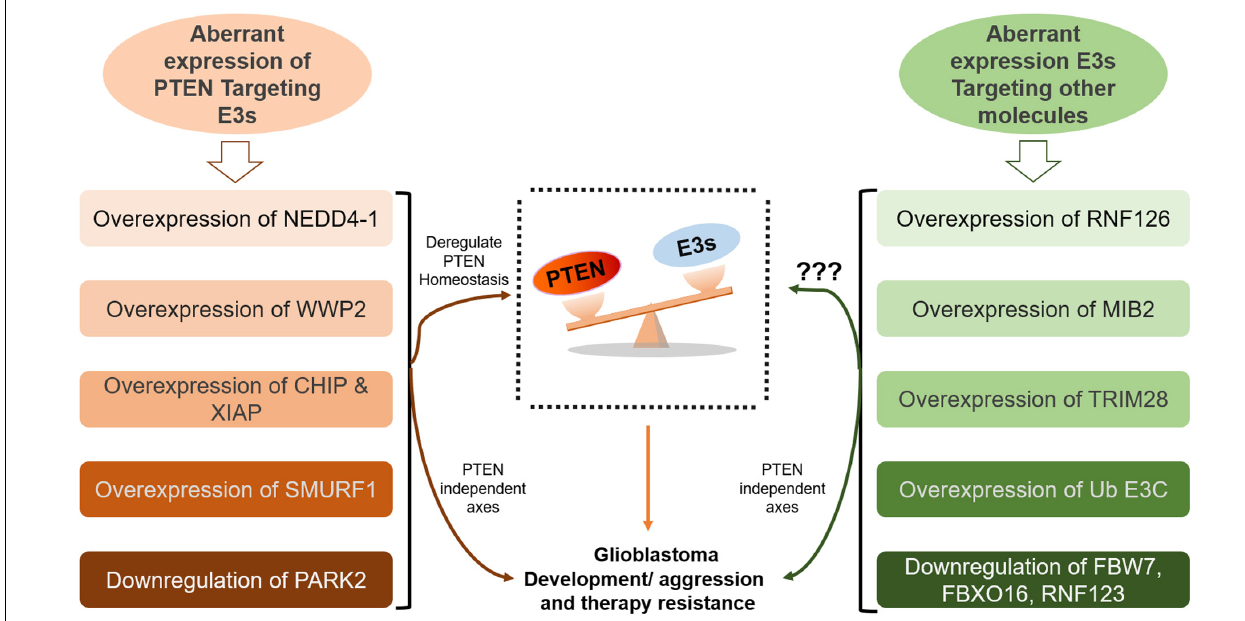
FIGURE 3 | Aberrant homeostasis of PTEN mediated by ubiquitination in GB. Many E3 ligases directly disrupt the homeostatic balance of PTEN tumor suppressor leading to GB development and aggression (on the left side). However, the role of many E3s, which promote GB by deregulating other pathways, in the regulation of PTEN function demand further investigation (on the right